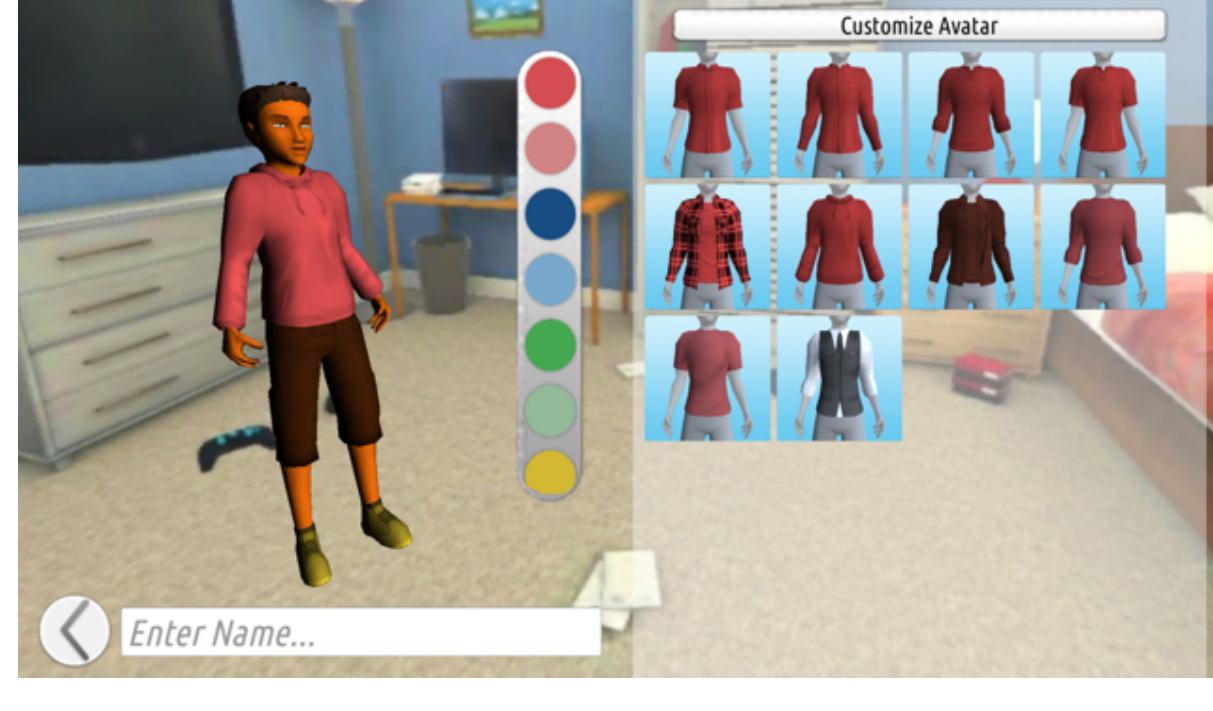
Figure 2. Screenshot of character design.